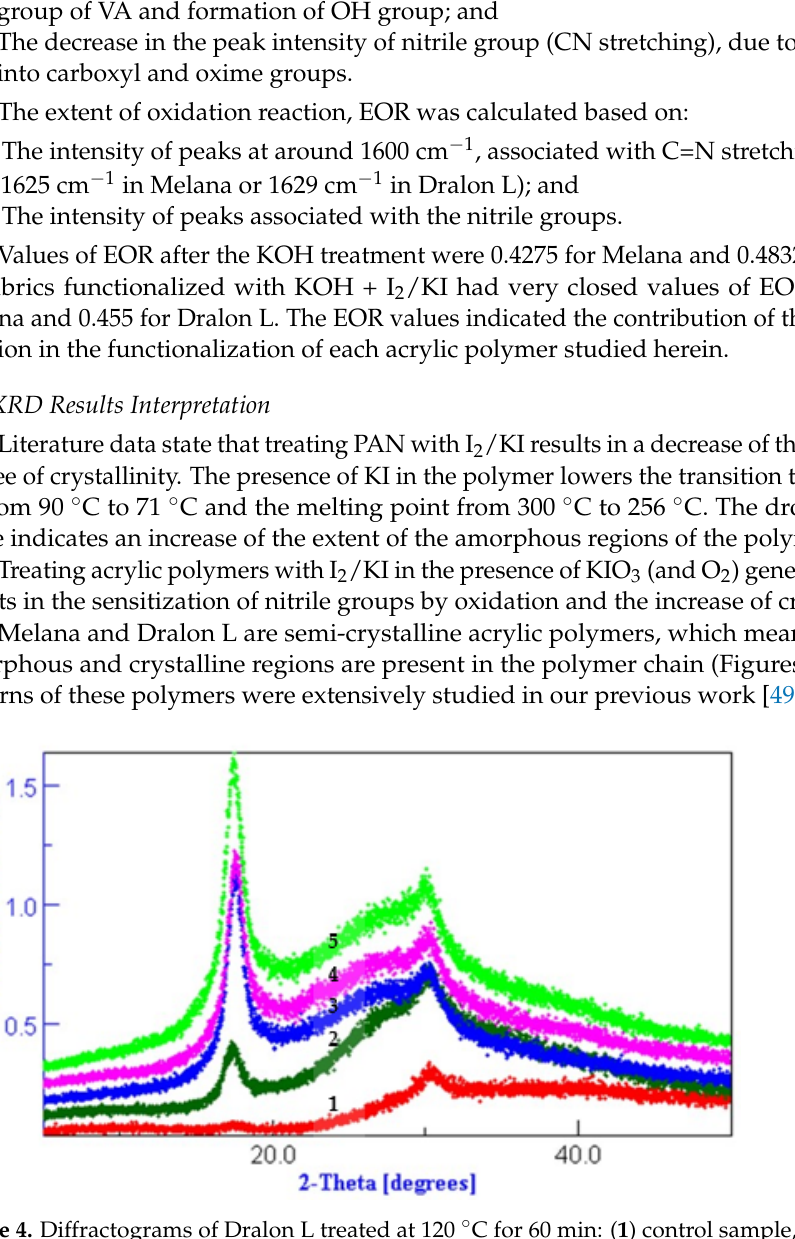
Figure 5. Diffractograms of Dralon L treated at 120 °C for 30 min with excess of reagents: ( 1 ) con- trol sample, ( 2 ) sample V1 with KOH plus iodine, and ( 3 ) sample V2 with KOH plus iodine.